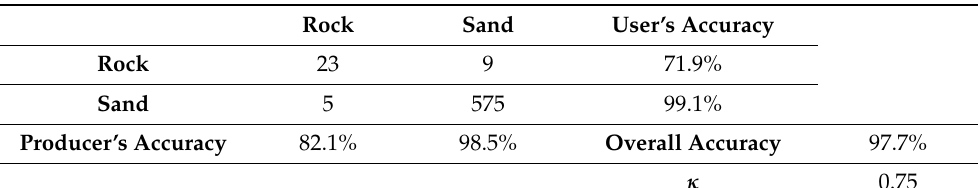
Figure 6. Substrate map of the Elbow of the west Florida shelf with 10 m x 10 m resolution determined through supervised (random forest) classification ( a ) and the corresponding Shannon entropy map describing the uncertainty of the classification of each pixel ( b ). Table 2. Confusion matrix and user’s (row-wise) accuracy, producer’s (column-wise) accuracy, overall accuracy, and Cohen’s Kappa statistic ( κ ) for the substrate map of the Elbow of the west Florida shelf derived using supervised